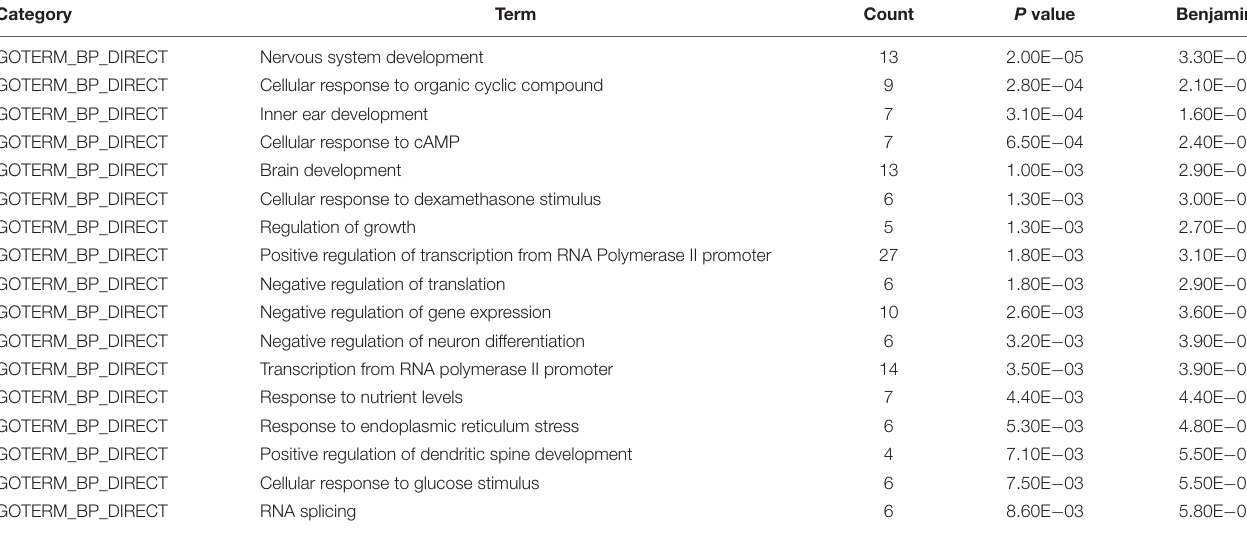
TABLE 1 | Biological process analysis of the target genes of differential expression microRNAs using DAVID bioinformatics resources. Category Term Count P value Benjamini